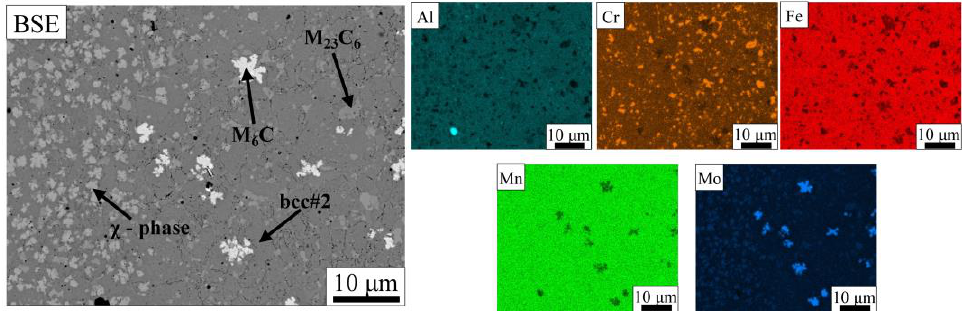
Figure 5. SEM-EDX mapping of the bulk sample of the area, which was in contact with the graphite die.